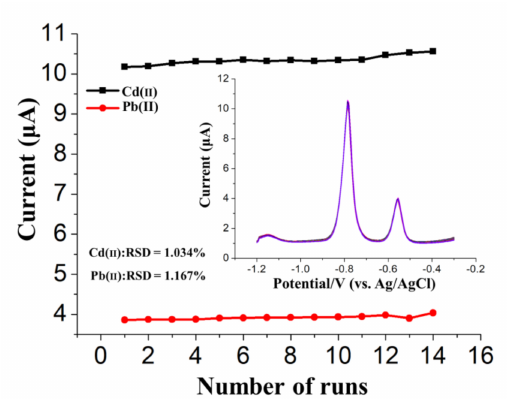
Figure 9. Stripping current measurements of 50 µ g / L Cd(II) and 25 µ g / L Pb(II) on the (BiO) 2 CO 3 -rGO- Nafion / GCE in 0.2 M acetate bu ff er (pH 5.0). The insets correspond to the data collected from every SWASV response for a total of six times.